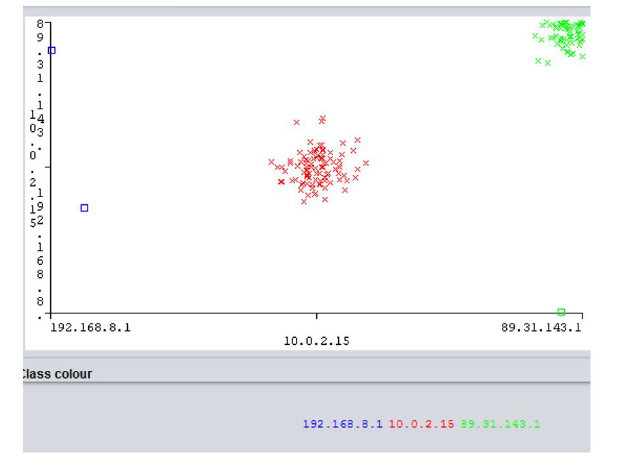
Figure 7. Random Forecast